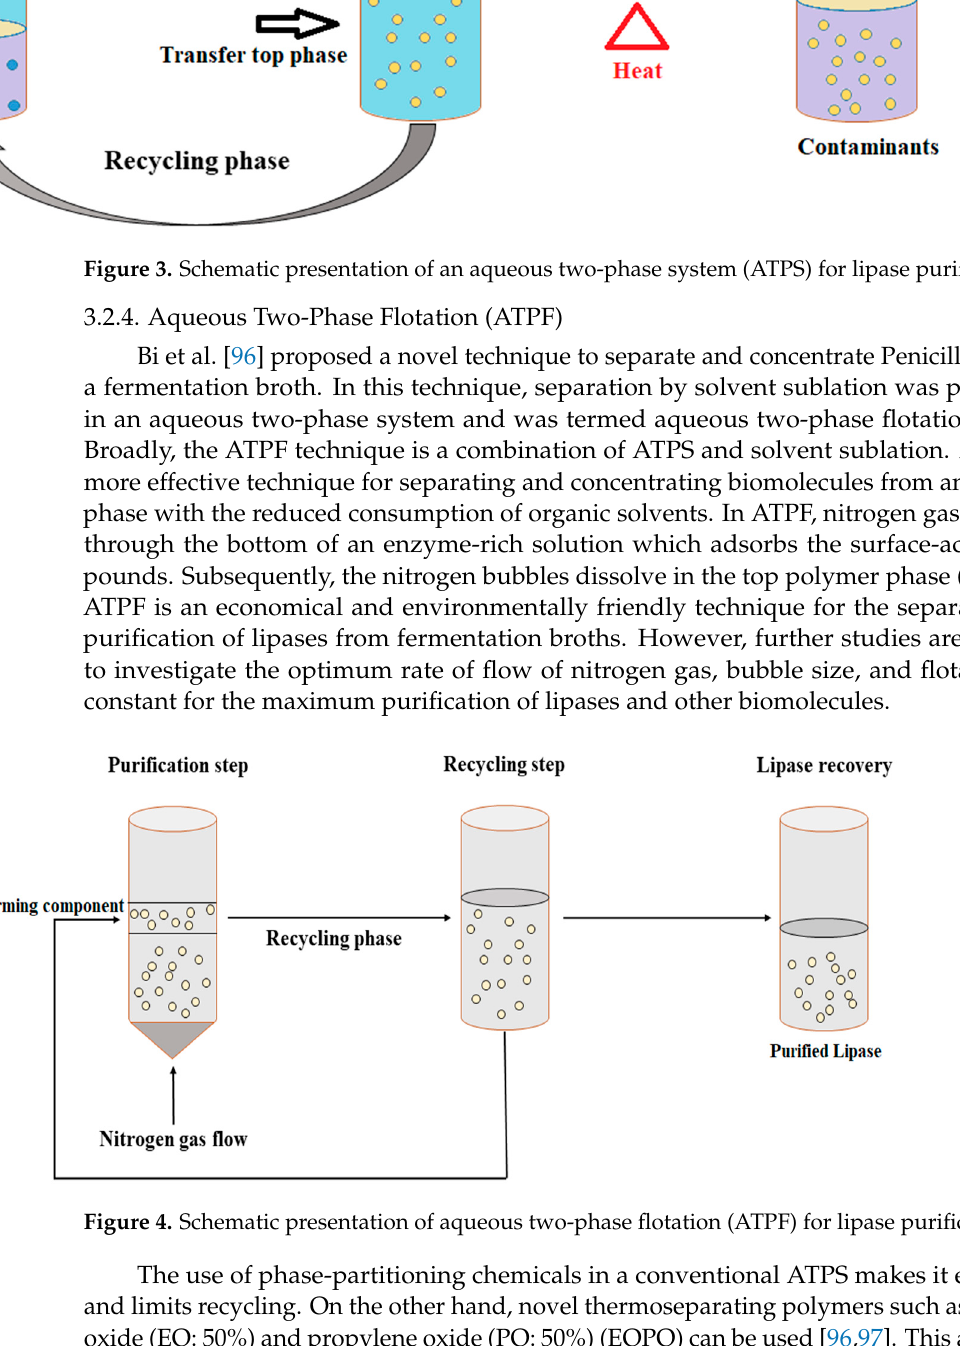
Figure 4. Schematic presentation of aqueous two-phase flotation (ATPF) for lipase